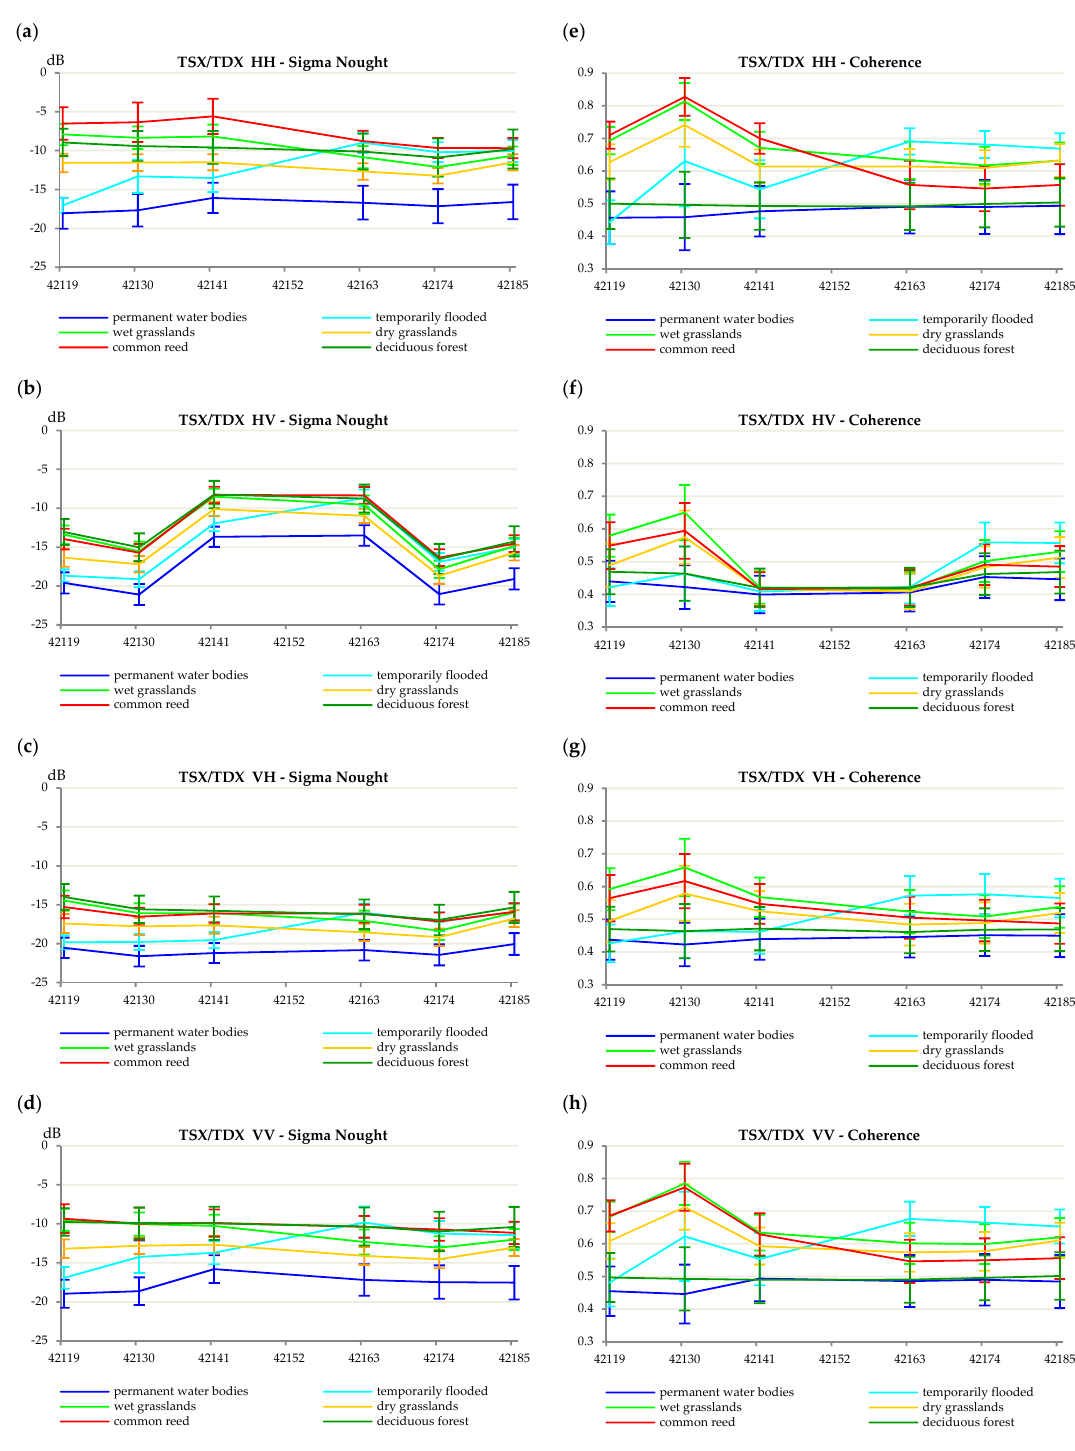
Figure 9. Sigma nought (dB) ( a – d ) and coherence values (mean and standard deviations) ( e – h ) for the time series of TSX/TDX polarimetric acquisitions for the final six thematic classes.